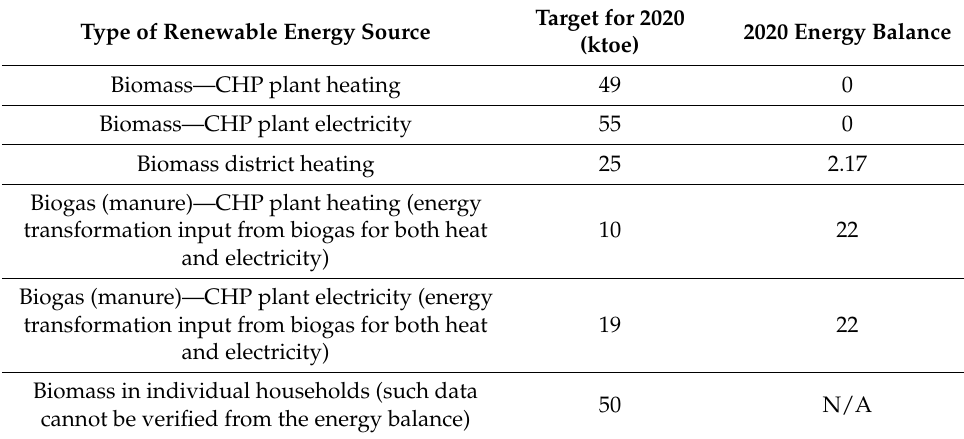
Table 1. Targets for additional biomass use in 2020